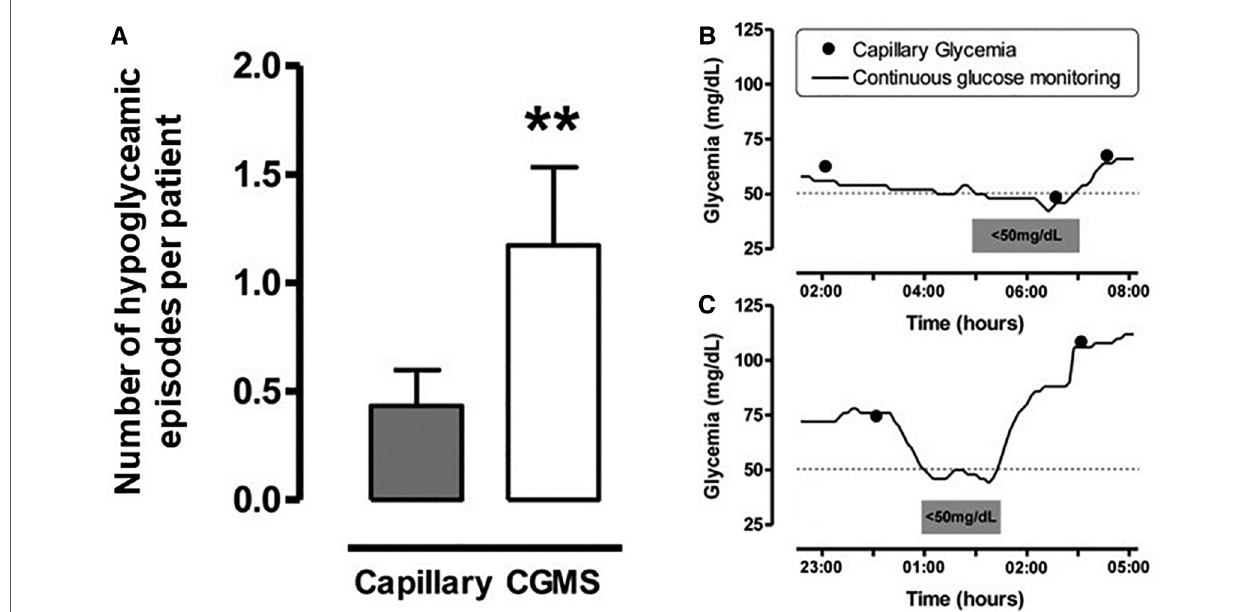
FIGURE 2 Number of Hypoglycaemia episodes per patient in those with CGM and examples of hypoglycaemic episodes Left panel ( A ): Number of hypoglycaemic episodes per patient detected by capillary blood glucose testing every 4 hours or from masked CGM data. Y-axis label modi fi ed from the reference. Hypoglycaemia was de fi ned as <50mg/dl (2.8 mmol/L), number of episodes expressed as mean±SE p <0.01 (Left panel). Right panel ( B ) and ( C ): Examples of hypoglycaemic episodes. Figure reproduced from Uettwiller F, Chemin A, Bonnemaison E, Favrais G, Saliba E, Labarthe F. Real-time continuous glucose monitoring reduces the duration of hypoglycemia episodes: a randomized trial in very low birth weight neonates. PLoS ONE . 2015 Jan 15;10(1):e0116255. doi: 10.1371/journal.pone.0116255. PMID: 25590334; PMCID: PMC4295867. Under the terms of the “